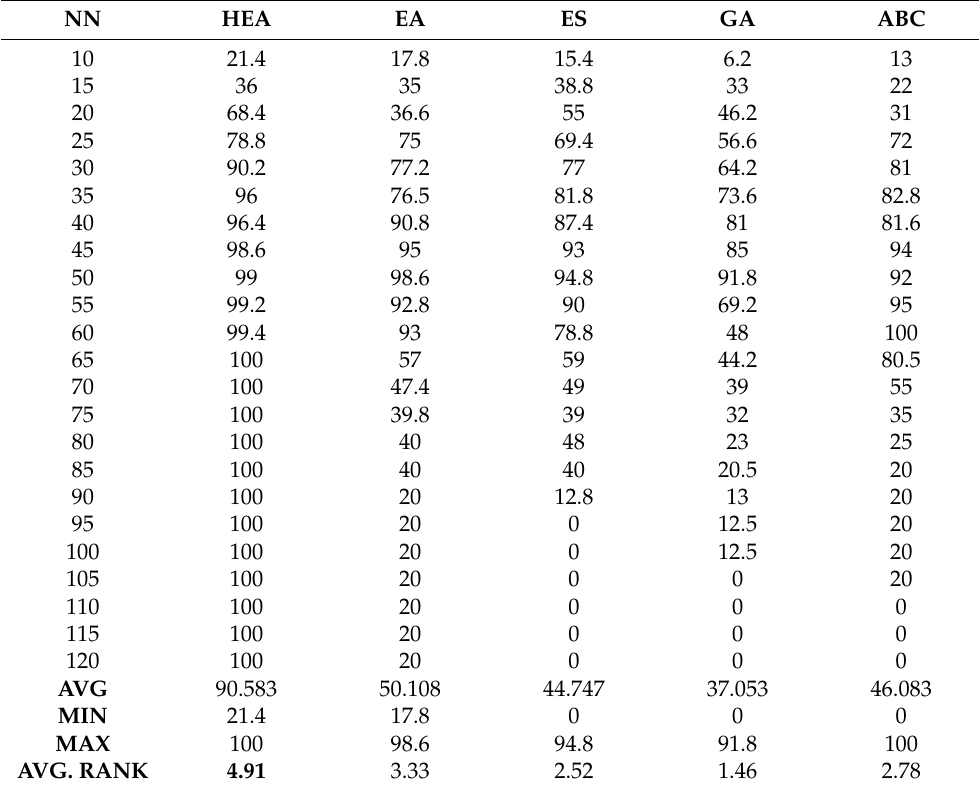
Figure 11. Gower–Legendre Similarity Index ( GLI ) for different DHNN-RAN k SAT models. Figure 11. Gower – Legendre Similarity Index (GLI) for different DHNN-RAN k SAT models. Table 10. Tabulated TNV values for different DHNN-RAN k SAT models. Table 11. Tabulated GLI values for different DHNN-RAN k SAT models. The notation * means no value has been generated in that particular point.